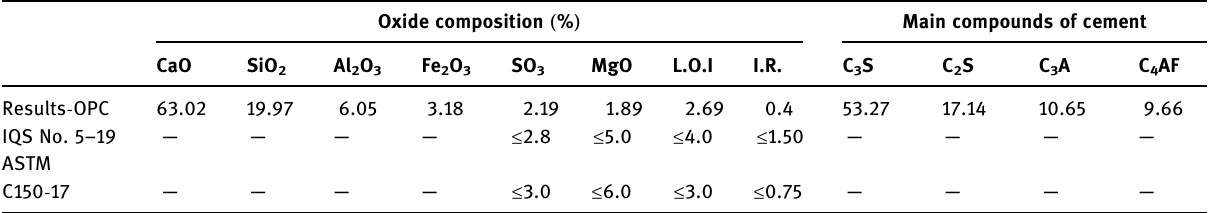
Table 1: Cement chemical properties